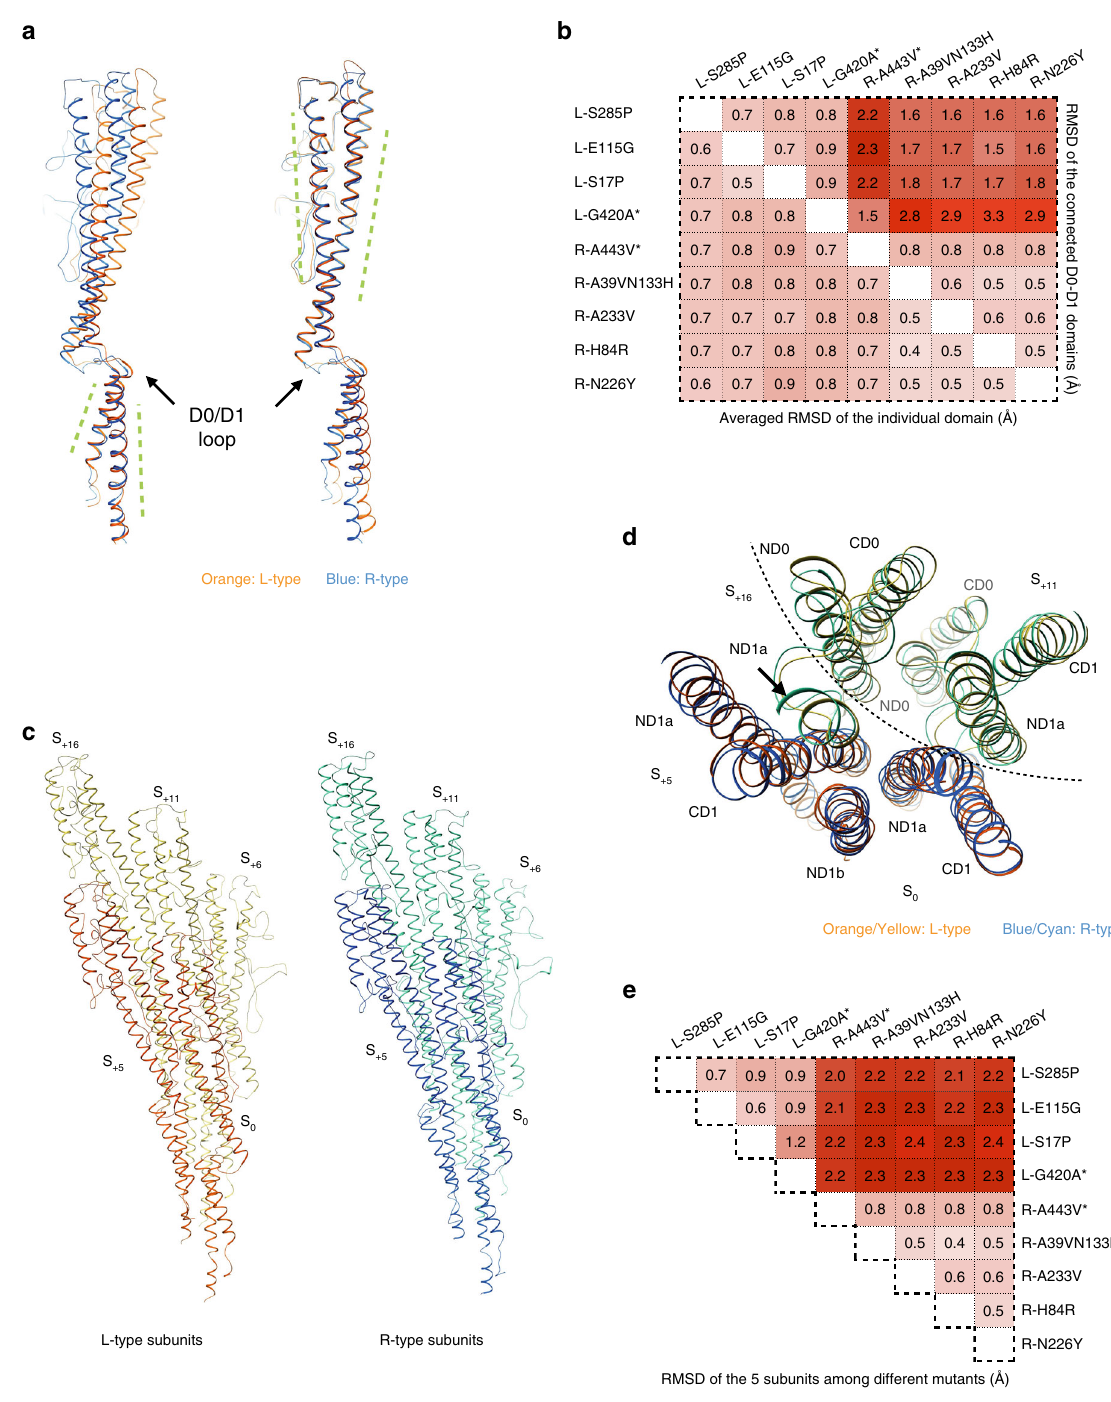
Fig. 3 Comparison of the C α backbones of L- and R- type structures. a Superposition of a single L-type ( orange , S285P) and R-type ( blue , N226Y) subunit of B. subtilis , by D0 domain ( left ) and D1 domain ( right ). b RMSD calculations of individual domains ( bottom left ) and RMSD calculations of the combined D0 plus D1 domains ( upper right ). Two P . aeruginosa mutants are labeled with an asterisk . The intensity of red corresponds to the RMSD level. c Five subunits of L-type ( yellow and orange , S285P) and R-type ( blue and cyan , N226Y) subunits, containing all unique contacts within the fi laments. d Comparison of the relative arrangement of these fi ve subunits from the horizontal plane ( yellow and orange : L-type S285, blue and cyan : R-type N226Y). e RMSD calculations of the complex of these fi ve subunits among all the nine fi lament